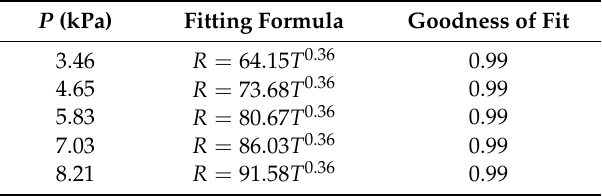
T (unit: s) is the injection time; R (unit: µ m) is the radius of the microdroplet.